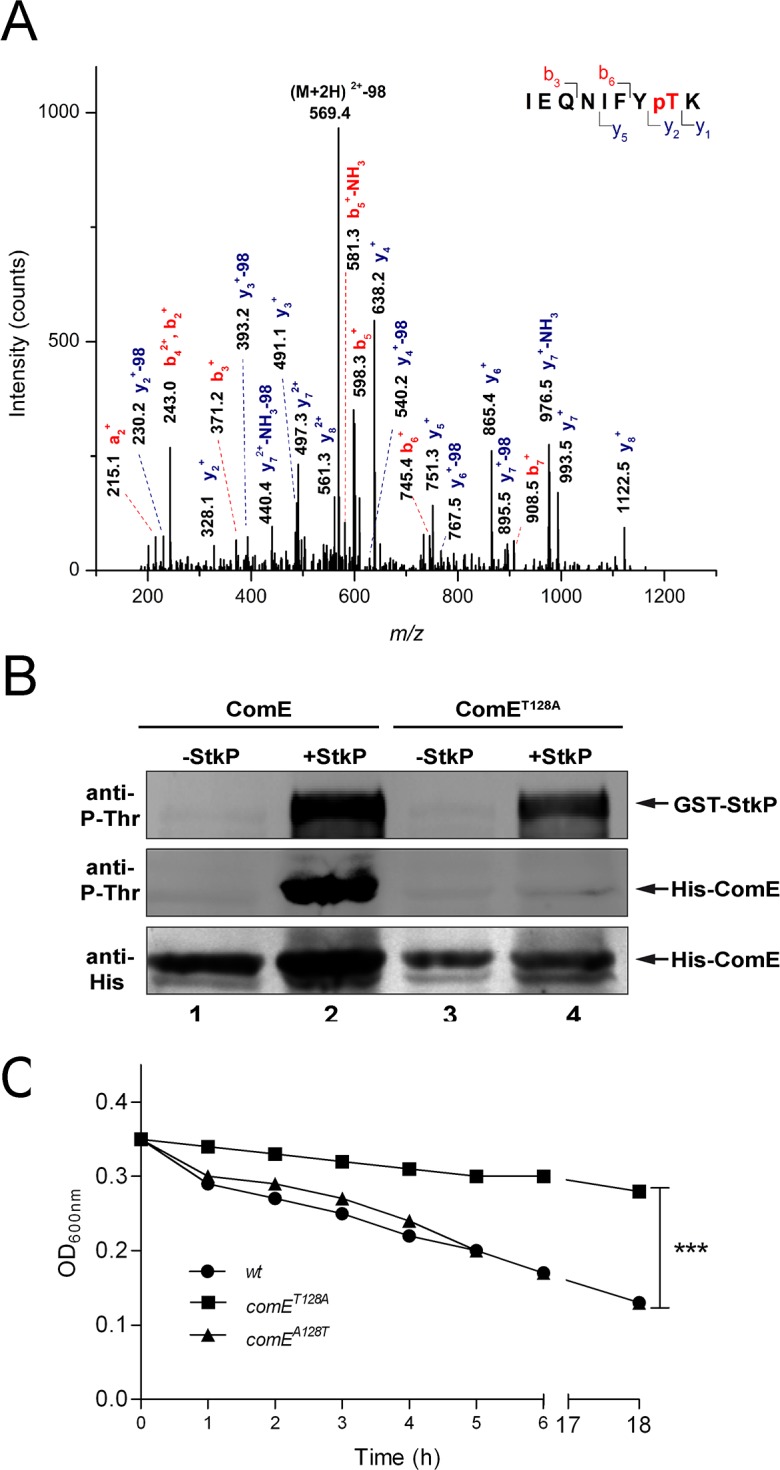
StkP phosphorylates ComE on the Thr128 residue to control ASIL.(A) To identify the phosphorylation site, tryptic peptides obtained from ComE previously incubated with StkP were analyzed by nano-LC-MS/MS. The figure shows the MS/MS spectrum of the di-charged ion of m/z 618.8 corresponding to the phosphorylated sequence IEQNIFYTK. C-terminal y ions are labeled in blue, while N-terminal a or b fragment ions are labeled in red. Ions containing pT residue present the phosphorylation characteristic neutral loss of 98 Da. Thr128 is unequivocally identified as the phosphorylated residue (Xcorr 3, 45; pRS score 148). (B) StkP phosphorylates ComE at Thr128. In vitro phosphorylation assays were performed with purified GST-StkP and Hisx6-ComEwt or Hisx6-ComET128A proteins mixed in kinase buffer at a StkP/ComE ratio of 1:20. Phosphorylated proteins were detected with an anti-phospho-threonine polyclonal antibody. Lane 1: Hisx6-ComE. Lane 2: Hisx6-ComE + GST-StkP. Lane 3: Hisx6-ComET128A. Lane 4: Hisx6-ComET128A + GST-StkP. (C) ASIL requires the Thr128 residue in ComE for lysis induction. Autolysis was determined as indicated in the legend of Fig 1. Lytic curves corresponding to specific mutants are indicated, which data is representative of at least three independent experiments. References: ***p> 0.001.